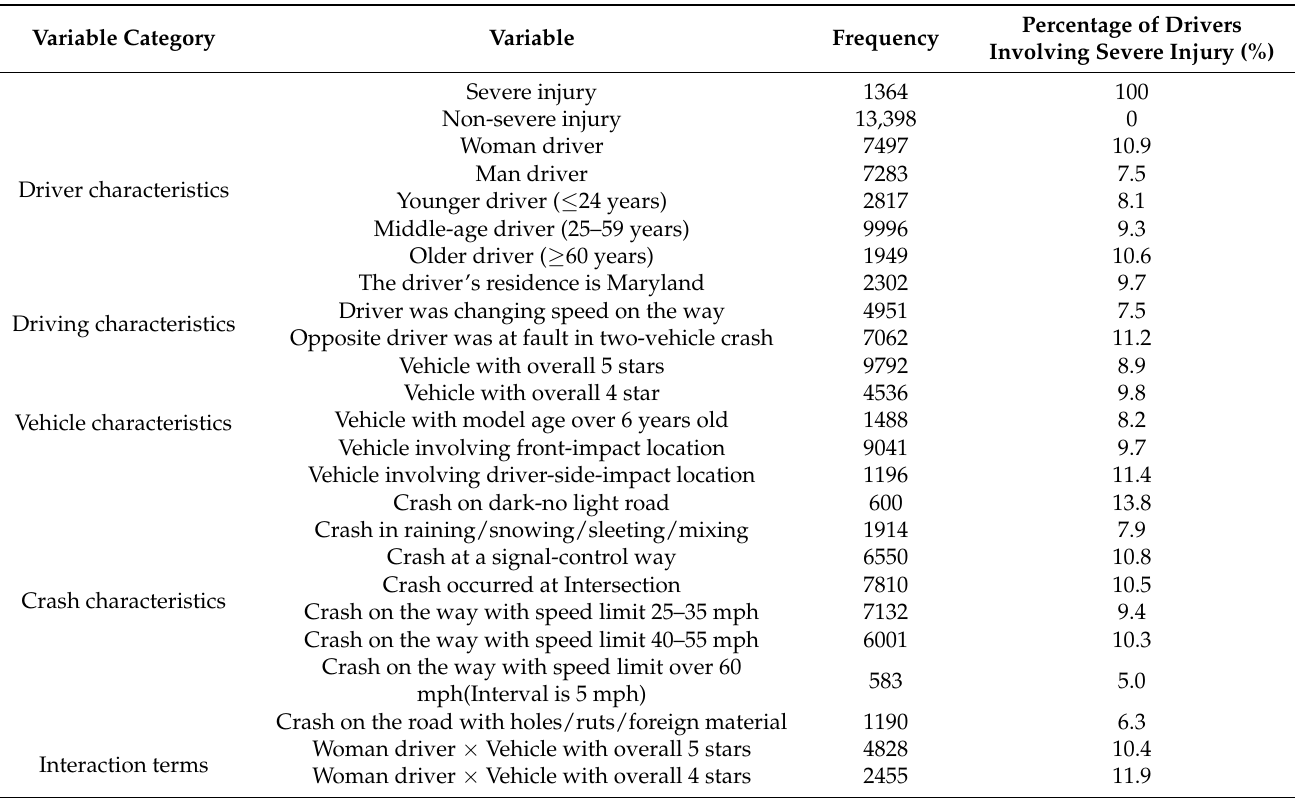
Table 1. Descriptive statistics of the two-vehicle crash data.